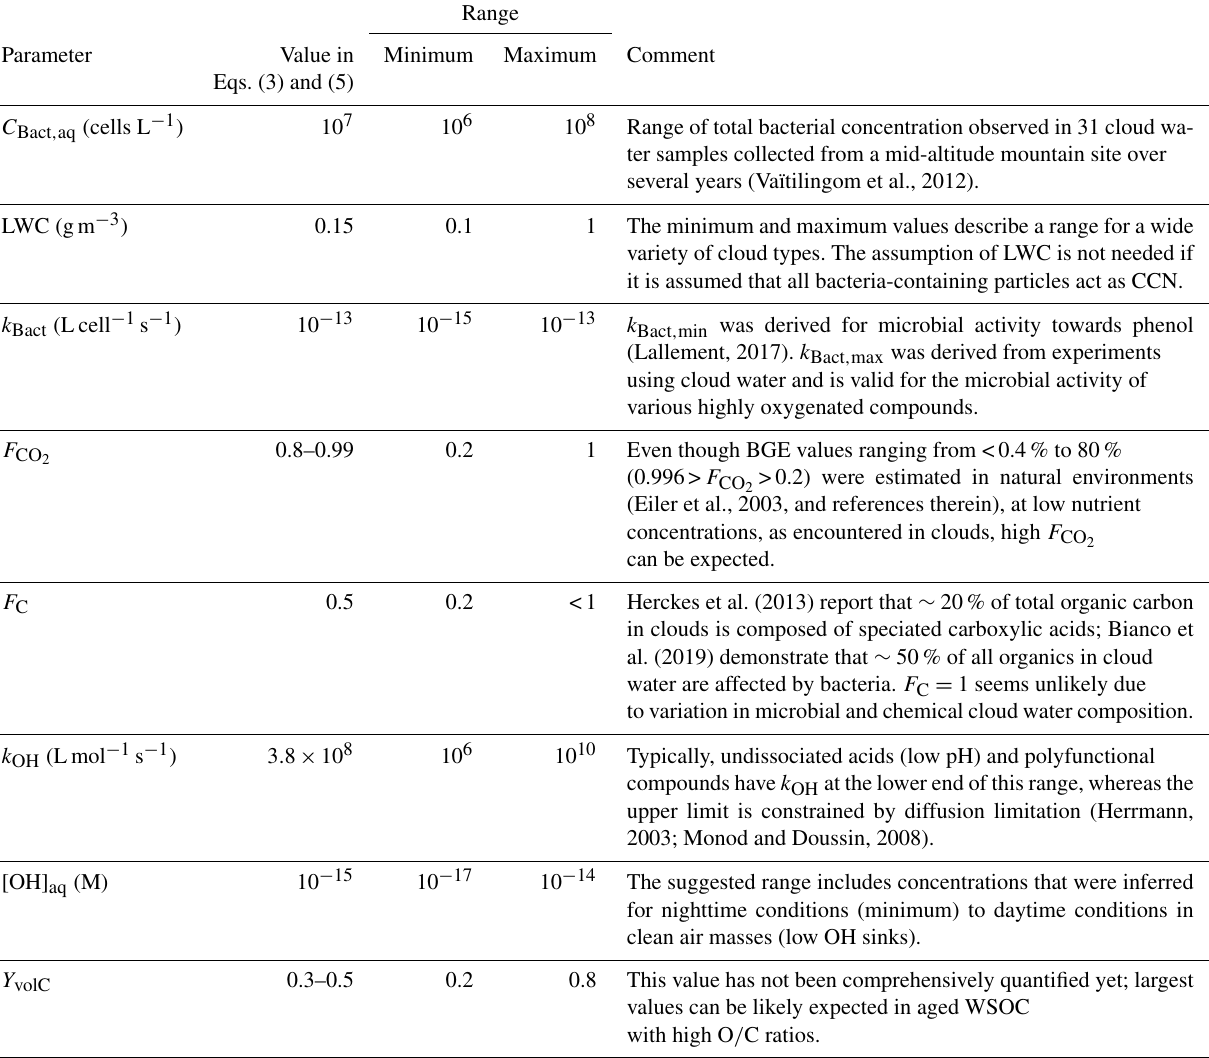
Table 4. Values for parameters in Eqs. (3) and (5) used in the estimate of WSOC loss by microbial and chemical processes and their minimum and maximum values. Range Parameter Value in Minimum Maximum Comment Eqs. (3) and (5) C Bact , aq (cells L − 1 ) 10 7 10 6 10 8 Range of total bacterial concentration observed in 31 cloud wa- ter samples collected from a mid-altitude mountain site over several years (Vaïtilingom et al., 2012). 0.1 1 The minimum and maximum values describe a range for a wide variety of cloud types. The assumption of LWC is not needed if it is assumed that all bacteria-containing particles act as CCN. (Lallement, 2017). k Bact , max was derived from